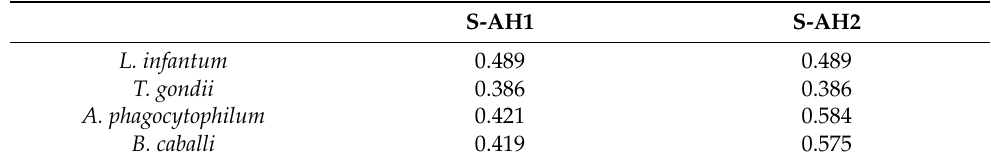
Table 2. Agreement between serum and aqueous humor of wild rabbits for the detection of